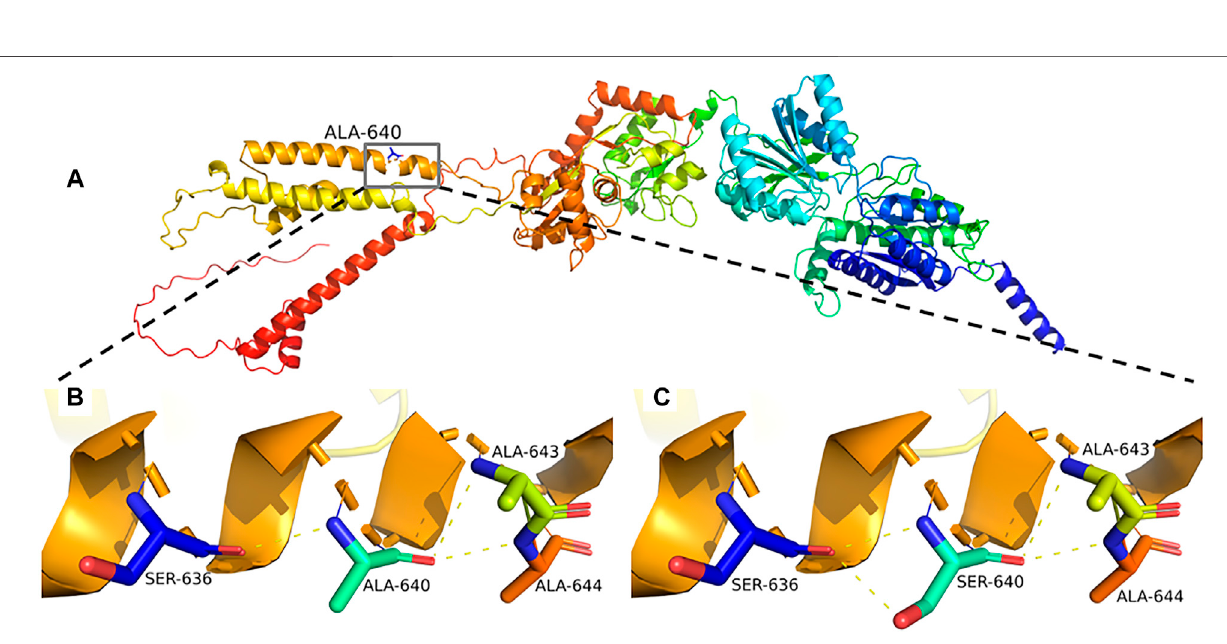
Frontiers in Genetics |